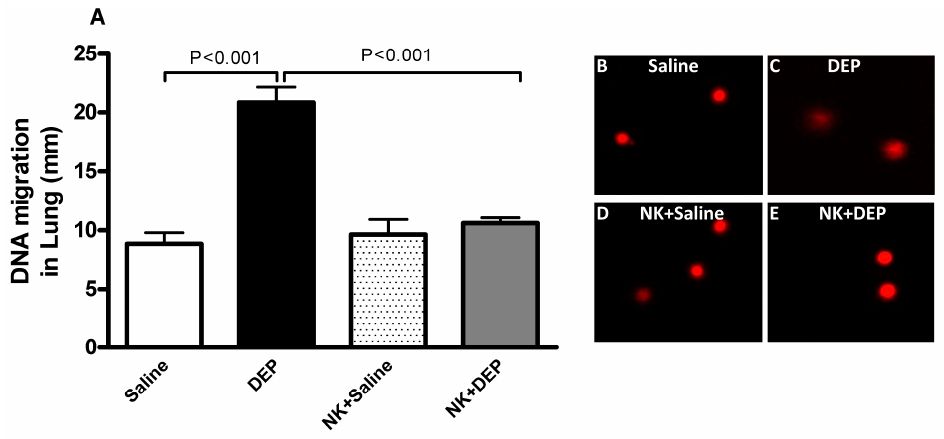
Figure 5. DNA migration (mm) in the lung tissues ( A ) evaluated by Comet assay, 24 h after intratracheal instillation of either saline or diesel exhaust particles (DEP, 30 µ g/animal), with or without nootkatone (NK) pretreatment. Data are mean ± SEM ( n = 5 in each group). Representative images, illustrating the quantification of the DNA migration by the Comet assay, under alkaline conditions, in control ( B ); DEP ( C ); NK+saline ( D ) and NK+DEP ( E